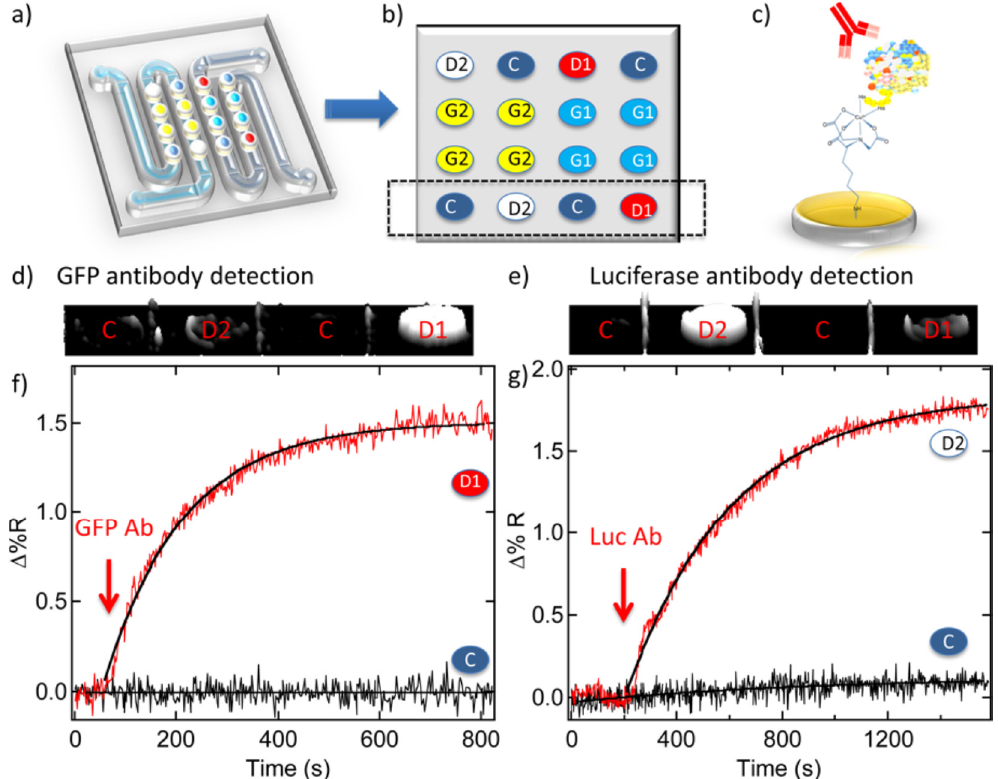
Figure 5. DNA-based protein microarrays for SPR imaging biosensor application ( a ) Five-component DNA microarray; ( b ) Spatial diagram of the five components on the DNA microarray; ( c ) Schematic binding of antibody onto protein microarray; ( d,e ) SPR imaging taken before and after binding the antibody to ( d ) D1 and ( e ) D2; ( f ) Real-time SPR imaging adsorption kinetics of anti-GFP binding onto D1; ( g ) The similar adsorption kinetics of anti-luciferase binding onto D2. (Reprinted with permission